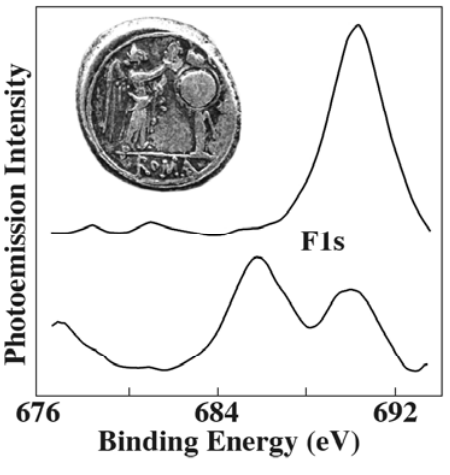
Figure 12. Use of photoelectron spectromicroscopy to study the microchemical composition of a Roman coin (the optical microscopy image). The local spectra taken after sputtering reveal the unexpected presence of fluorine below the surface. Data extracted from